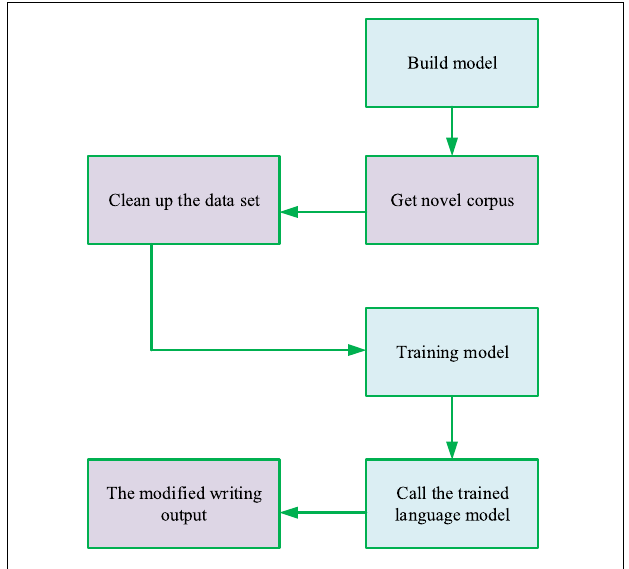
FIGURE 8 | Design and implementation of intelligent modification